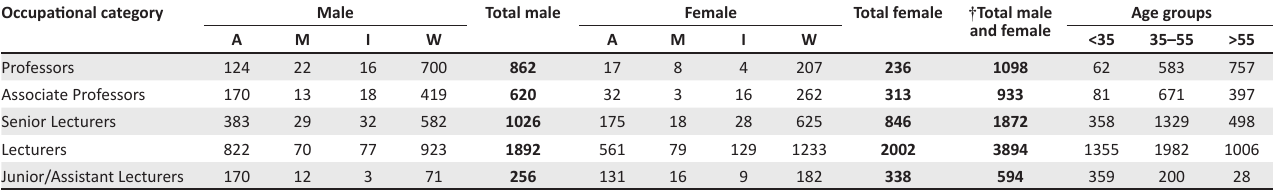
TABLE 1: Total number of permanent full-time academics within higher education on 01 April 2011. Occupational